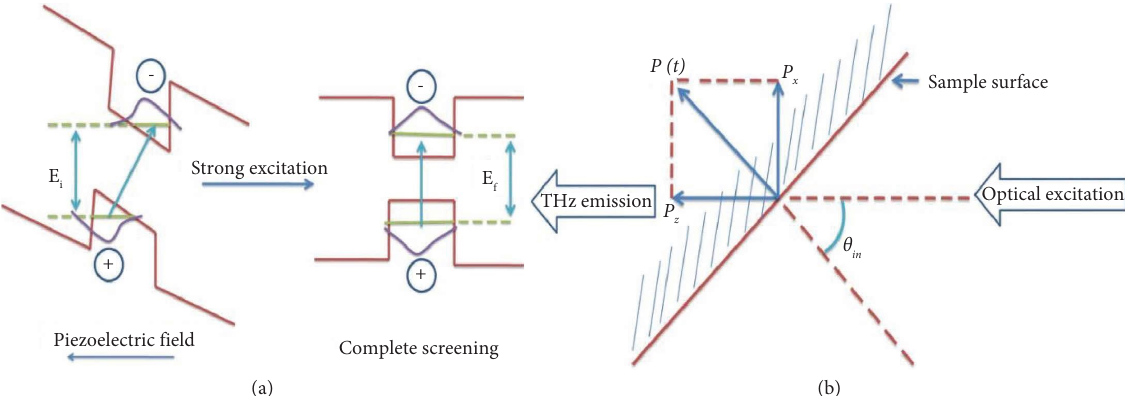
Figure 1: (a) Principle of the optically induced screening of a QW. (b) Excitation geometry for the successful THz emission from